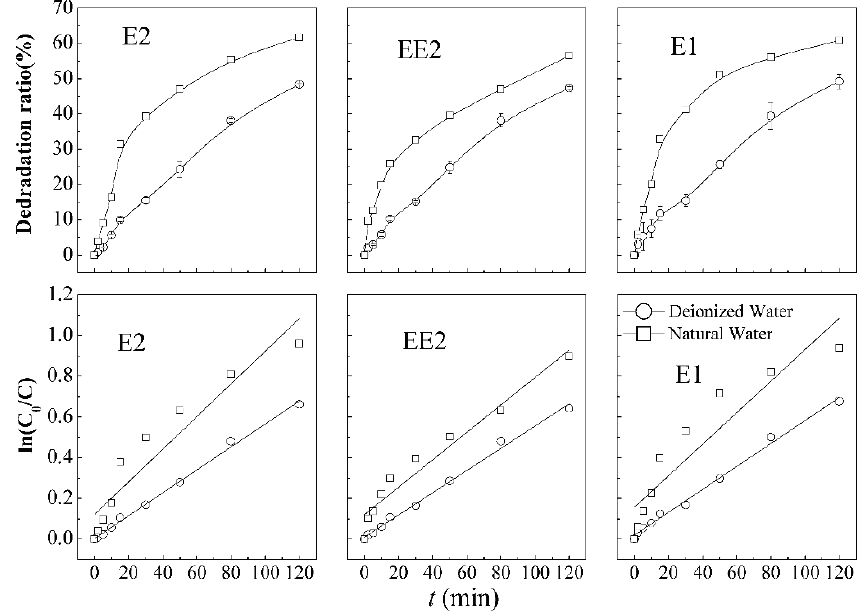
Figure 6. Steroid estrogens degradation curves and first order kinetic models in combination process under different aqueous